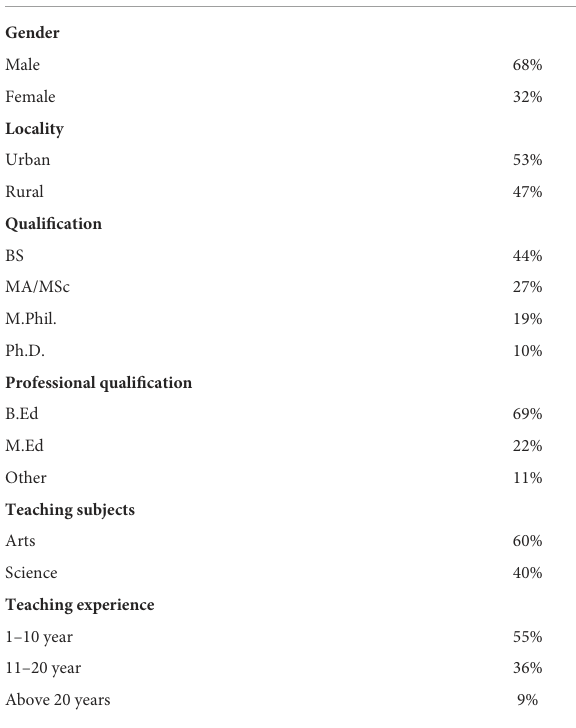
TABLE 1 Demographic statistics of all